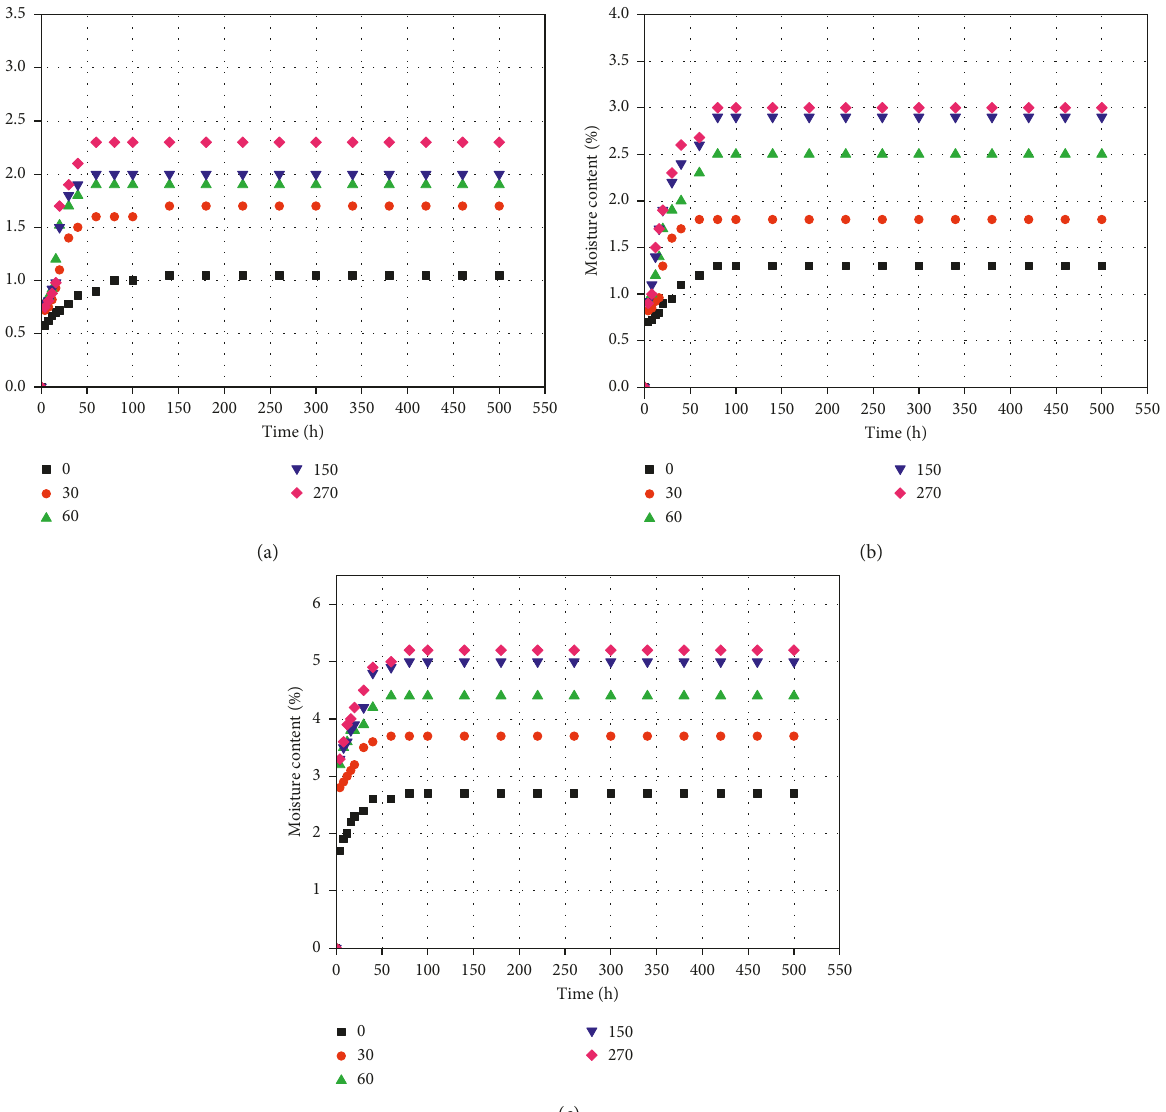
Figure 2: Moisture absorption curve at the temperature of 30 ° C at (a) RH 40%, (b) RH 60%, and (c) RH